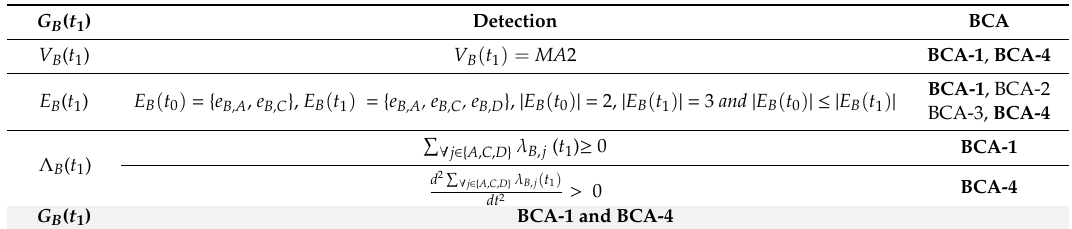
Table 5. Detection of BCA-1 and BCA-4 on host B at t 1 in Scenario